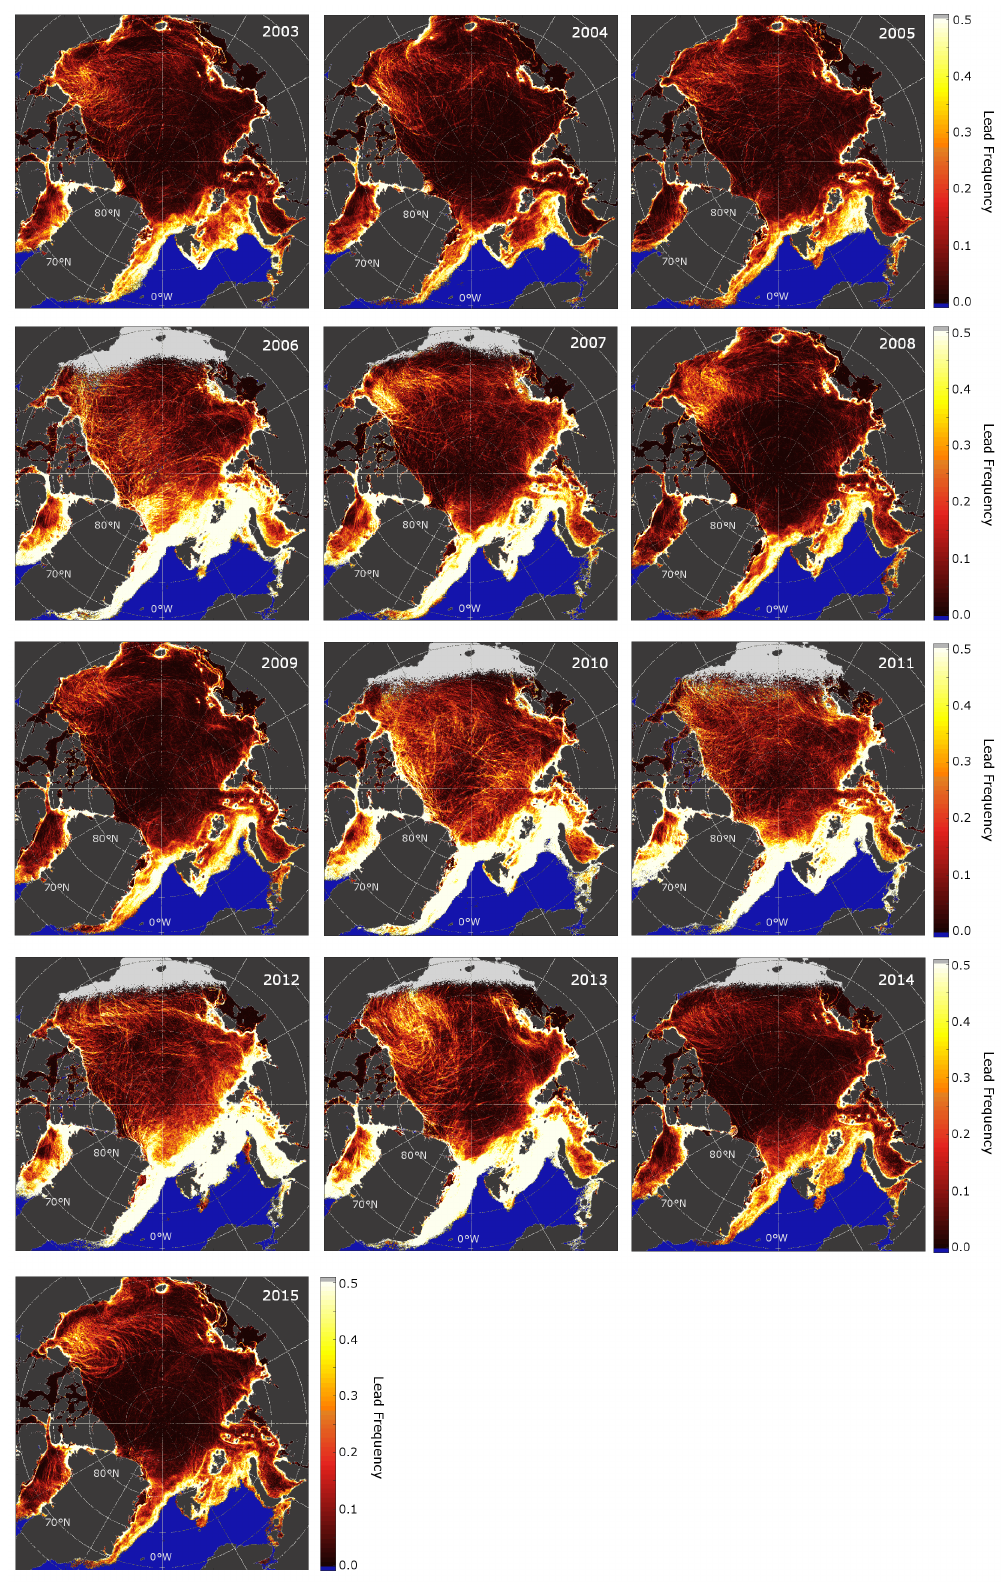
Figure 4. Annual lead frequencies, January to April, 2003–2015, frequency values are cut off at 0.5 to better highlight the variability at lower values. Grey areas denote regions with a clear-sky frequency less then 15%. (In supplement: Monthly lead frequencies,